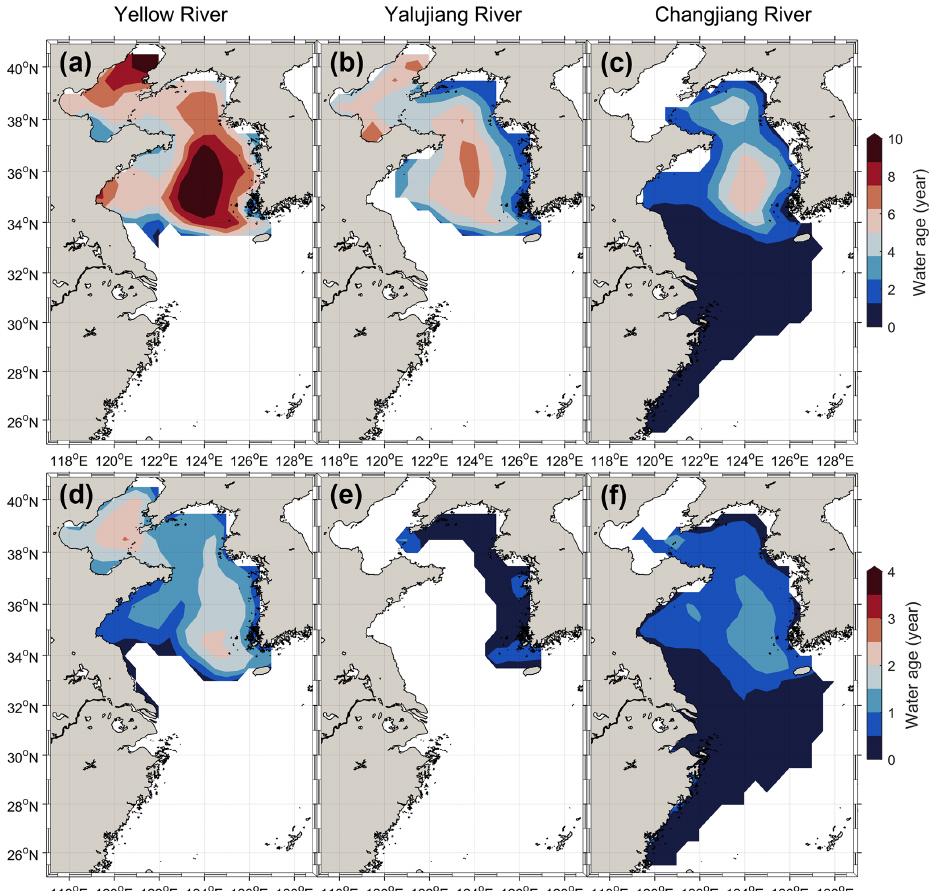
Figure 3. The annually and vertically averaged water age of the three rivers for the control run (a–c) and no-tide case (d–f) . Only results at locations with particle emergence probability of > 1% have been